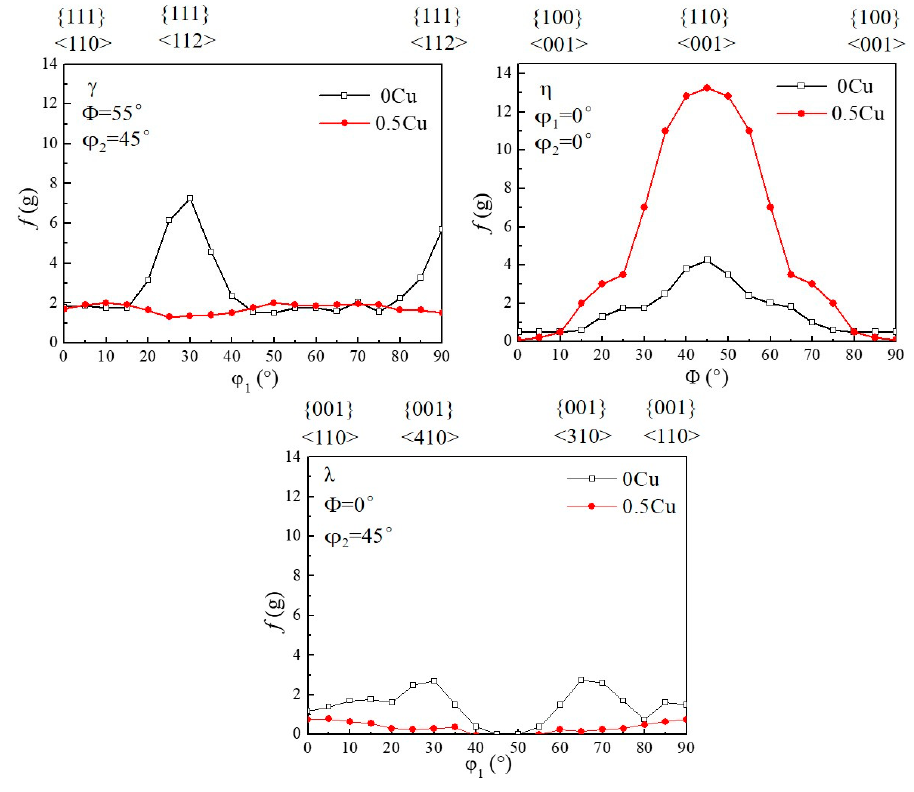
Figure 4. The orientation densities along γ , η and λ fibers of the sheets annealed at 900 °C for 10 min.